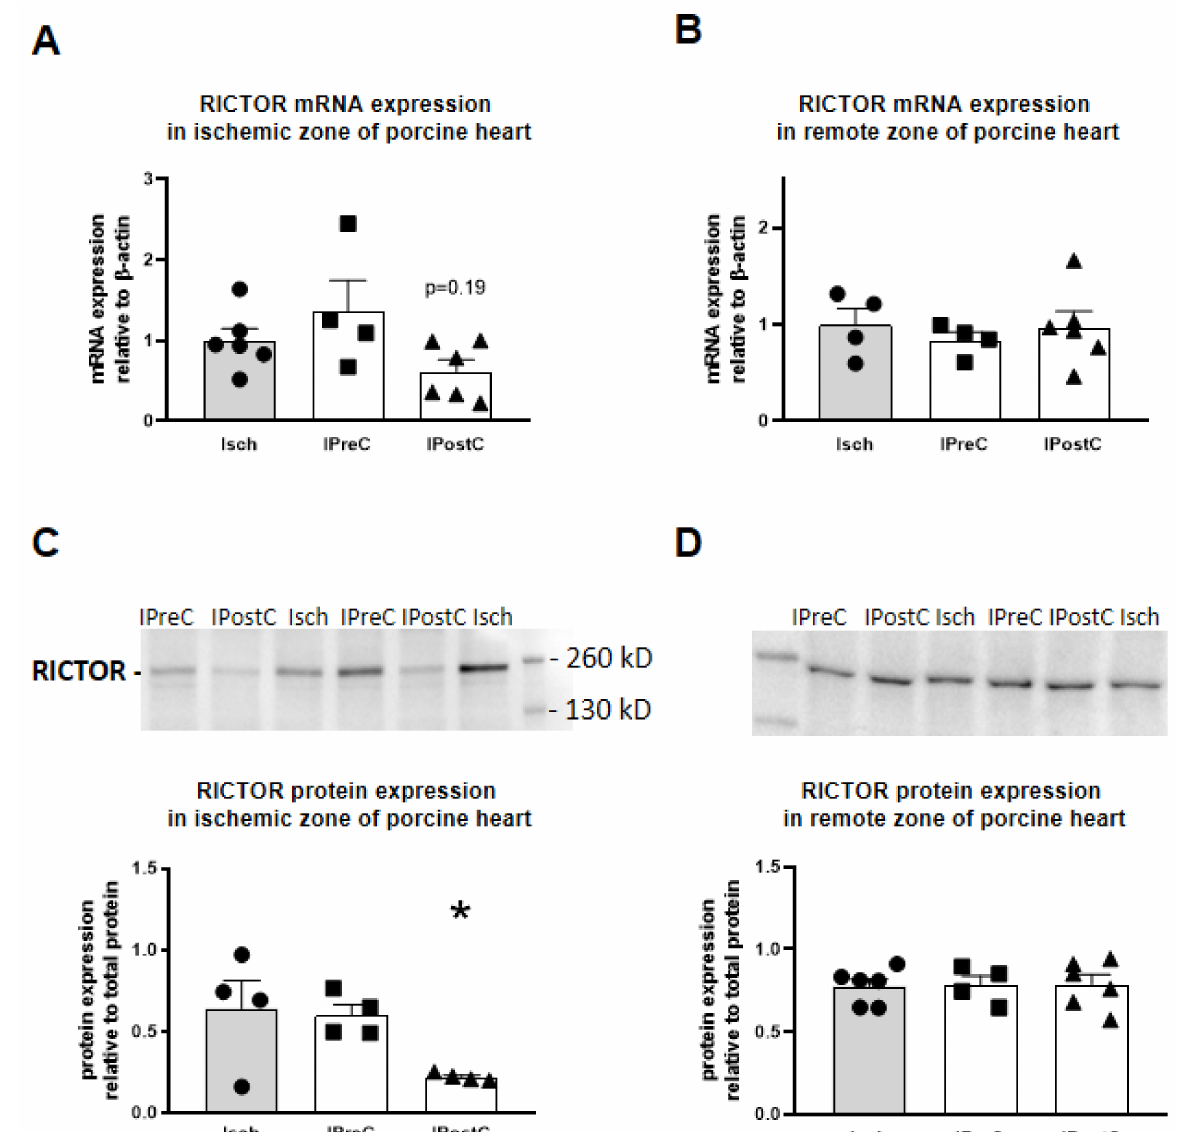
Figure 4. Central target hub, Rictor mRNA expression was measured with qPCR in the ischemic zone ( A ) and in the non-infarcted remote zone ( B ) of the porcine left ventricular myocardium. RICTOR protein expression was measured with Western blot in the ischemic zone ( C ) and in the non-infarcted remote zone ( D ) of the porcine left ventricular myocardium and normalized to total protein staining. Black circle, triangle and square signs represent individual data points. * p < 0.05 vs. Isch group, n = 4–6, one-way ANOVA followed by Dunnett post-hoc